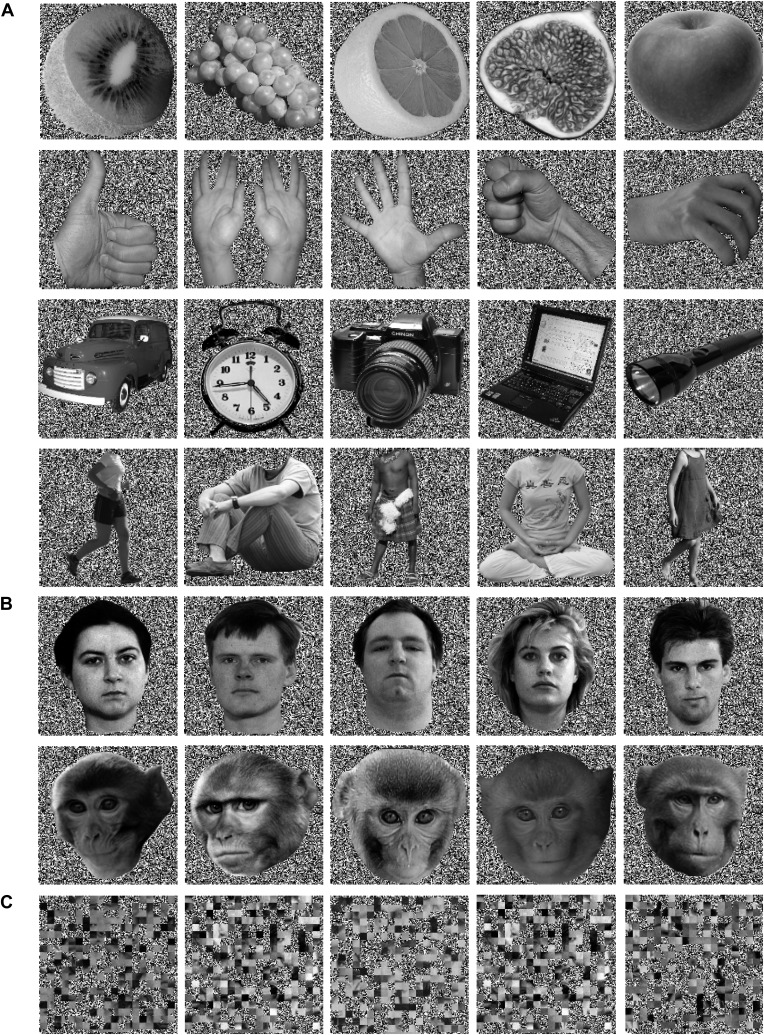
Examples of stimuli used in the 'passive face perception' experiment.(A) Biological and non-biological objects, (B) faces and scrambled versions of objects/ faces (lowermost row), (C) grid-scrambled images. The human faces were taken from the Nottingham Scans database (free for research use under the terms of a Creative Commons Attribution license, http://pics.psych.stir.ac.uk), all other images were from a variety of freely available sources.